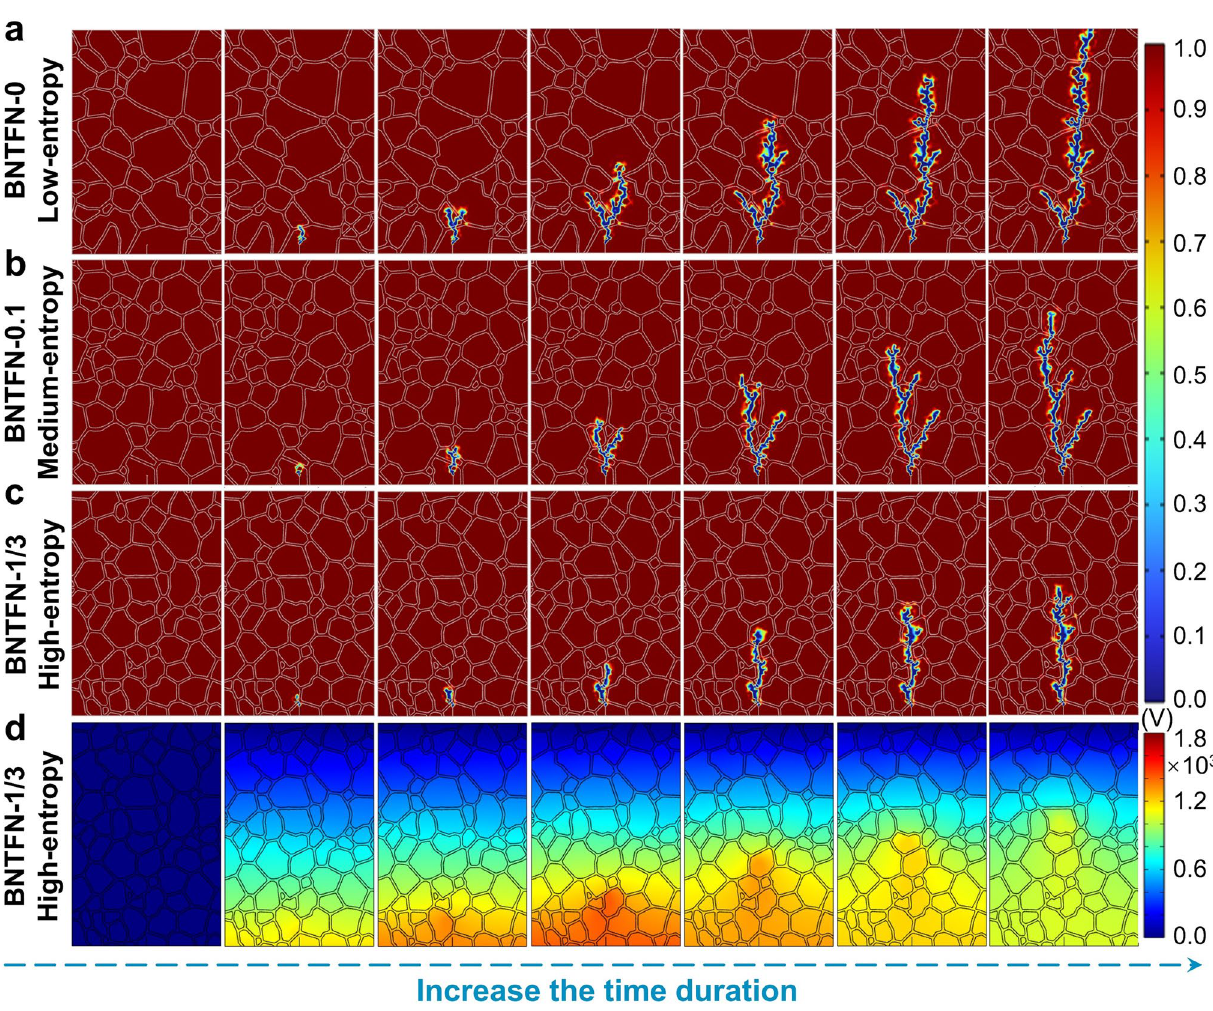
Fig. 5 Simulation of breakdown path. Breakdown path distribution or electrical tree evolution for ( a ) BNTFN-0, ( b ) BNTFN-0.1, and ( c ) BNTFN-1/3 ceramics from low entropy to high entropy. ( d ) Electric potential distribution for BNTFN-1/3 high-entropy